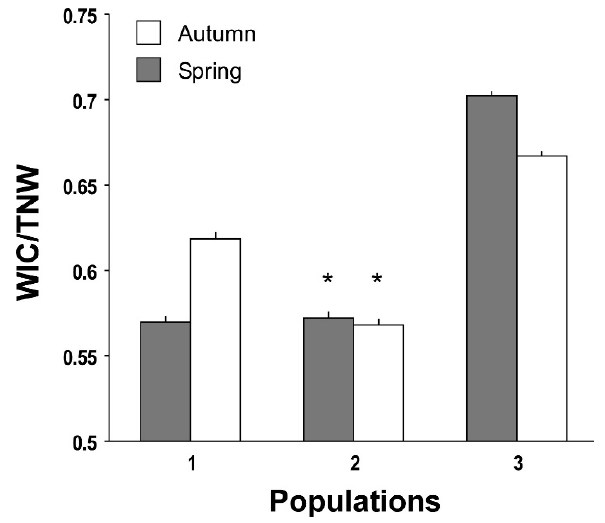
Figure 3. The ratio Within-Individual Component/Total Niche Width. Asterisks indicate that the ratios are significantly different from those expected by a null scenario hypothesising that all individuals sample equally from the population pool of prey items. Table 3. Summary of trophic niche metrics and number of analysed individuals per season (in square brackets) of the three Hydromantes ambrosii populations. WIC = within-individual component; BIC = between-individual component; TNW = total niche width; IS = individual specialisation. 95% bootstrapped confidence intervals are in round brackets. The estimated density ( N individuals/m 2 ) and, within parentheses, the total population size estimated by Ficetola et al. [48] of each population are included . † P > 0.20.